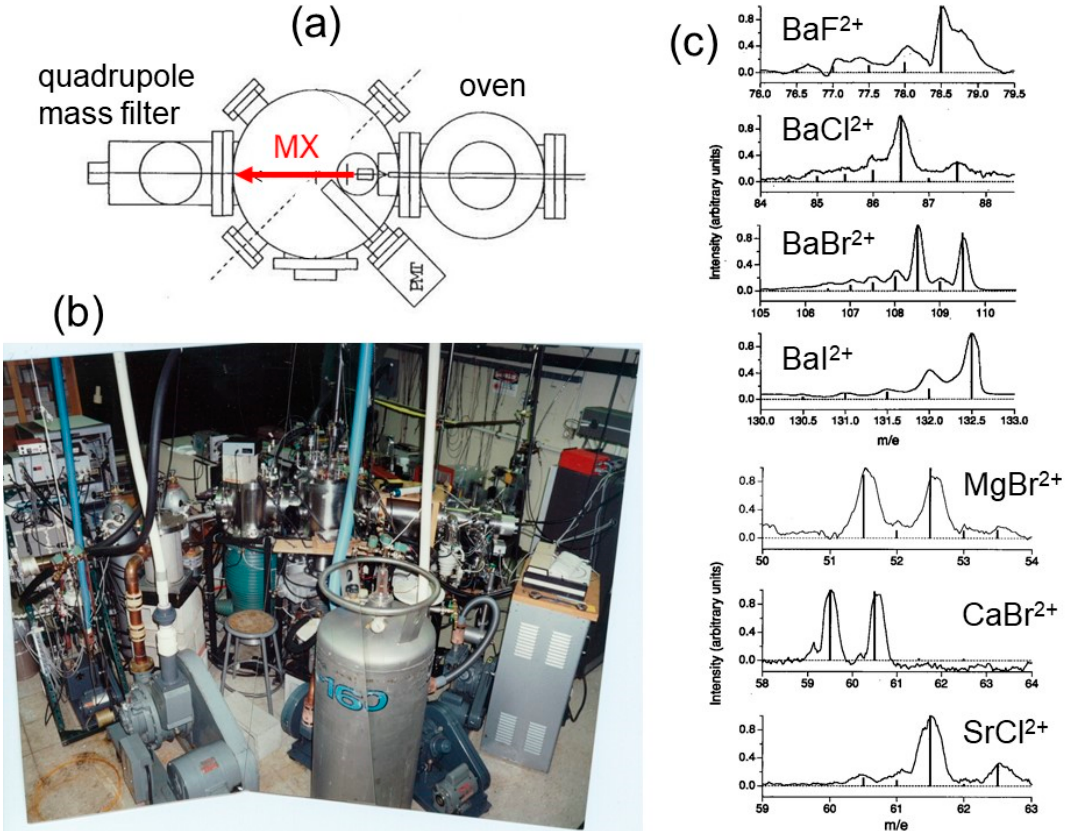
Figure 3. The molecular beam machine used in the Stanford experiment for the first generation of the alkaline earth monohalide dications in 1995: ( a ) a scheme of the experimental set up; ( b ) a picture of the apparatus that was working in the Zarelab; ( c ) the mass spectra obtained in the generation of BaX 2+ (X = F, Cl, Br, I), MgBr 2+ , CaBr 2+ , and SrCl 2+ molecular dications [63].